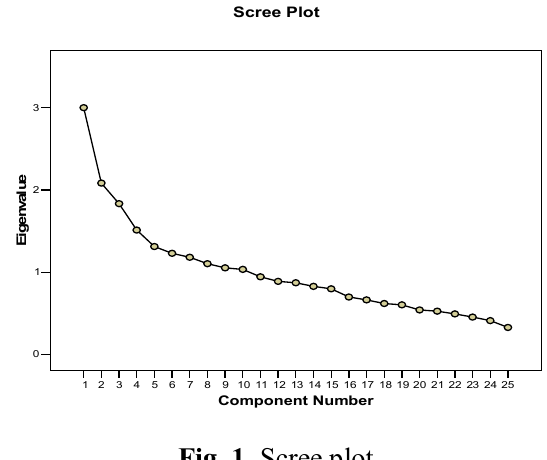
Fig. 1. Scree plot